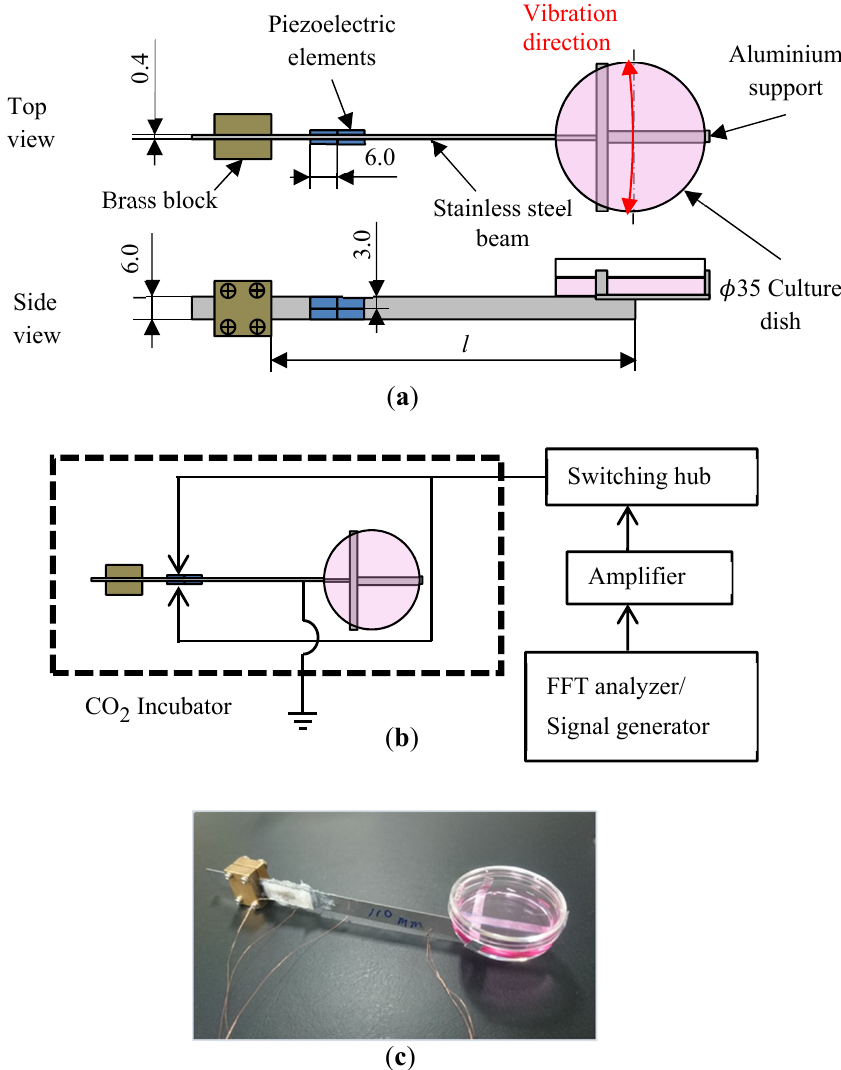
Figure 1. ( a ): Construction schematic of developed simple mini-vibration table by using bi-morph piezoelectric elements. ( b ): Control system of the mini-vibration table set inside CO 2 incubator. ( c ): Typical real view of the developed mini-vibration table with cell culture dish on its free end.